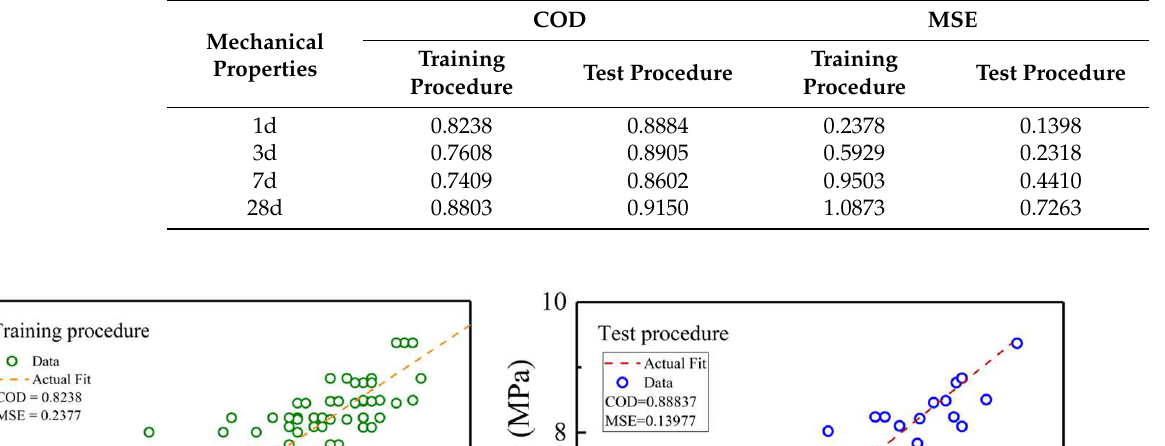
Table 7. COD and MSE value of predicted and actual value.